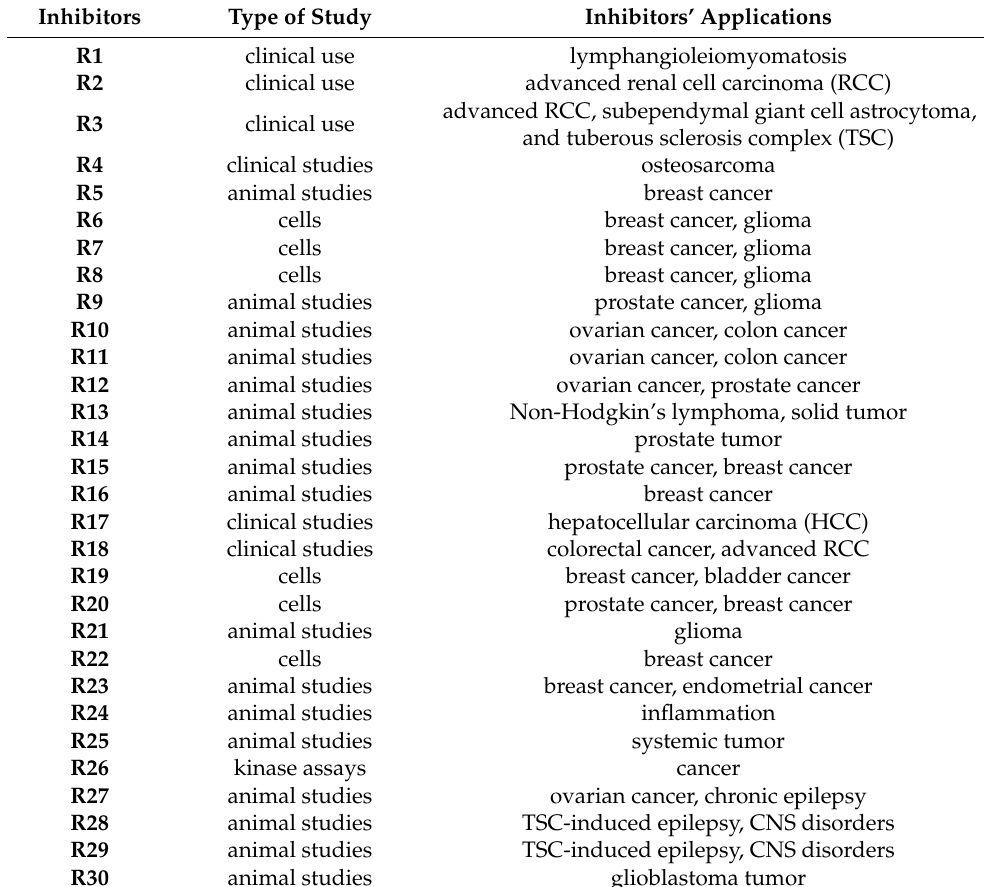
Table 1. Summarized study types and applications of mTOR